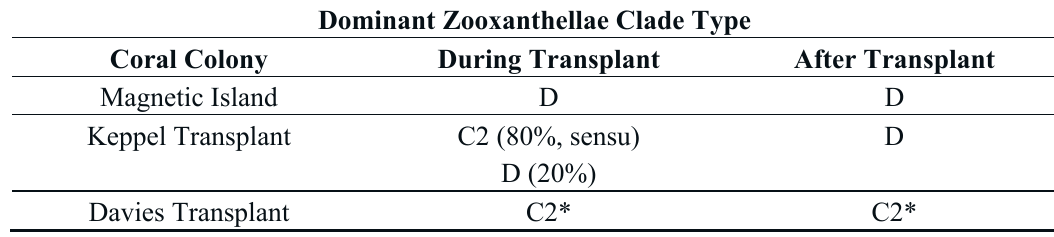
Table 1. Dominant zooxanthellae clade type for different coral colonies during and after transplantation. Dominant Zooxanthellae Clade Type During Transplant After